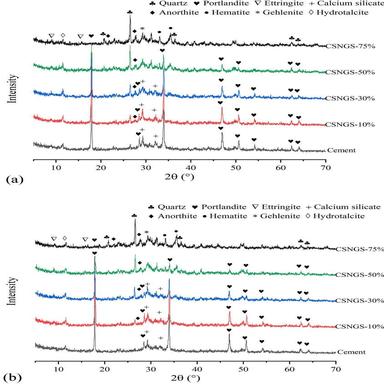
SEM/EDS of composite paste with different CSNGS contents, (a) cement (b) CSNGS-10 % (c) CSNGS-30 % (d) CSNGS-50 % (e) CSNGS-75 %.